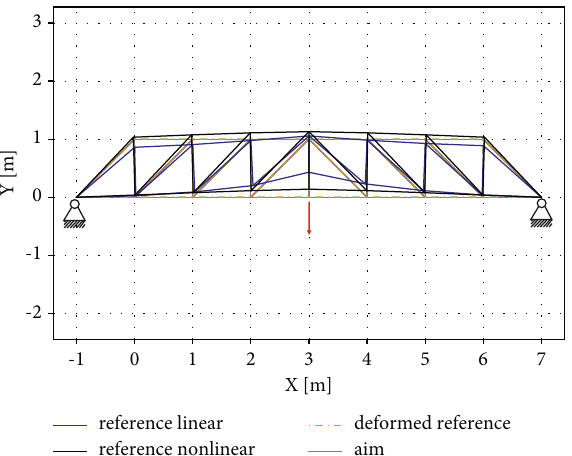
Figure 15: Bridge confgurations in x − y plane for z � 1. Te red arrow describes the vertical point